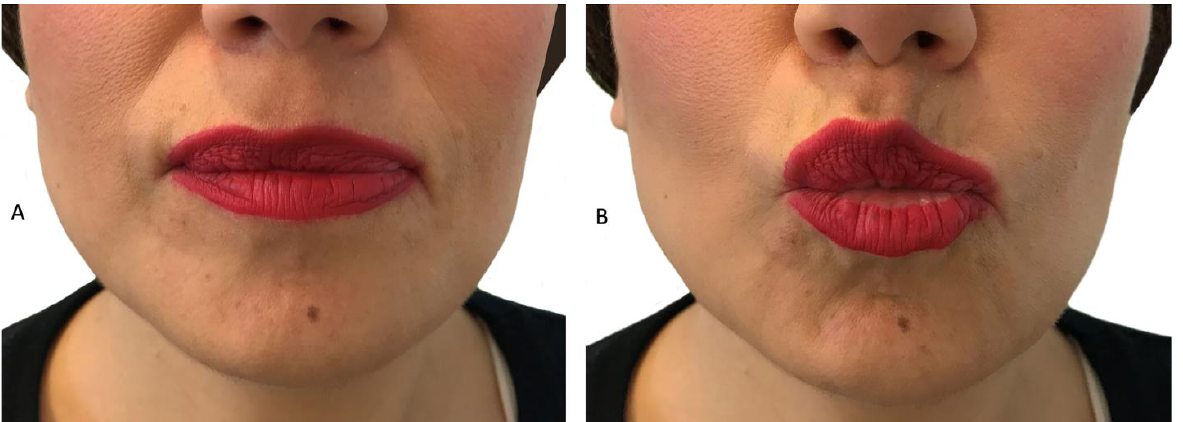
Figure 3. Patient P2: a female FSHD patient, 38 years old with late onset of the disease presenting with weakness of the left perioral muscle. The patient has the inability to whistle or drink with a straw. ( A ): patient with lips relaxed ( B ): patient trying to